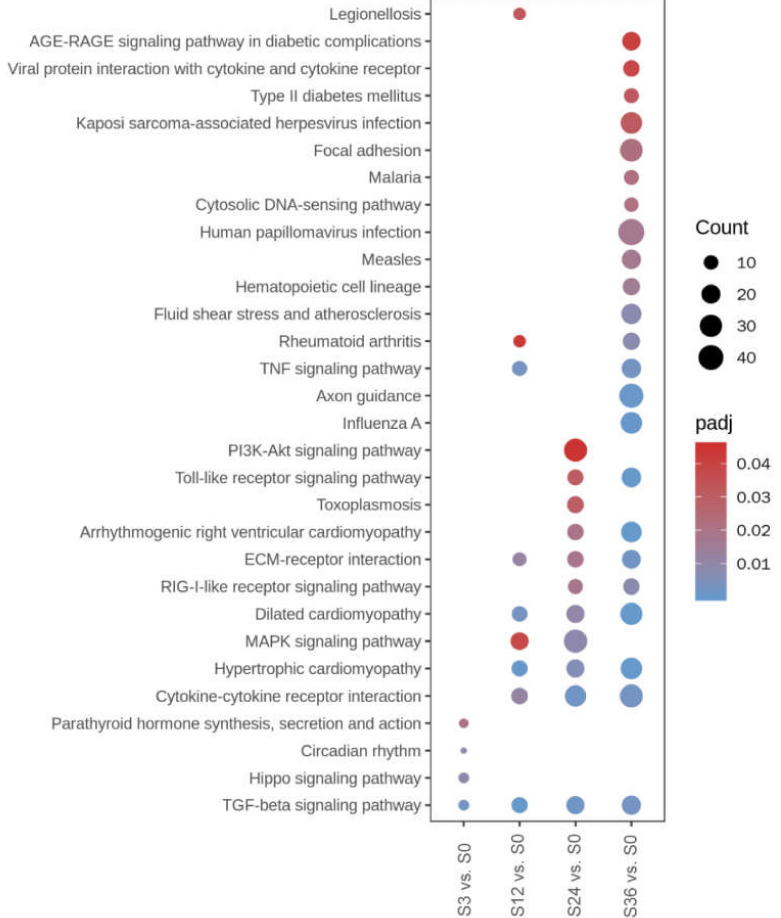
Figure 4. Significantly enriched KEGG pathways revealed by the KEGG pathway’s enrichment analysis of DEGs. The size of the dots indicates the number of DEGs enriched in the term (Count). The color of the dots indicates the adjusted p -value (padj), with a bluer color indicating a smaller padj value. Number of the enriched pathways increased with time, with the “TGF-beta signaling pathway” enriched from 3 to 36 hpi and “Cytokine-cytokine receptor interaction” enriched from 12 to 36